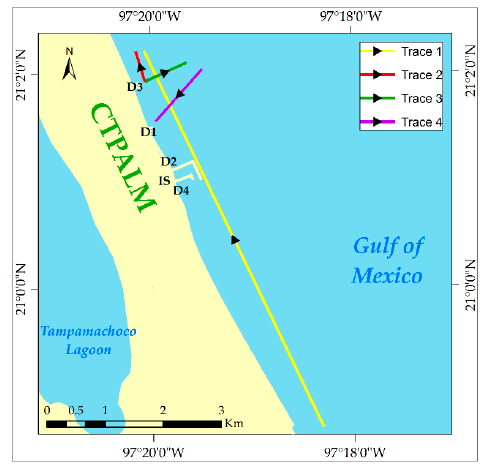
Figure 4. Location of the four traces performed using boat ‐ based CTD on 14 October 2011.